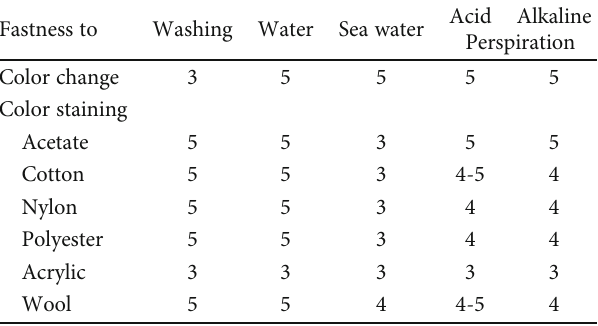
Table 2: Rating of color fastness to washing, water, sea water, acid, and alkaline perspiration of dyed fabrics at temperature 80 ° C for 60min at a dye concentration of 6% w / v and liquor ratio of 1 :30.